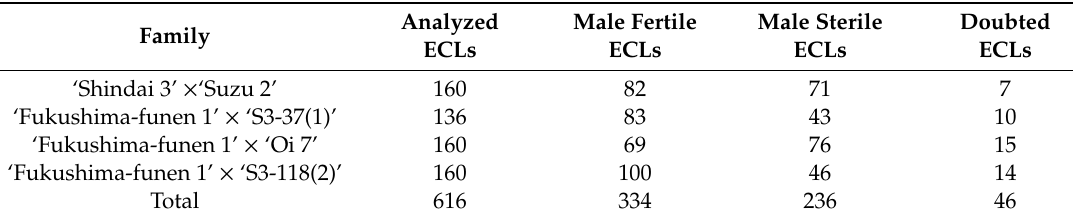
Table 2. Summary of marker-assisted selection (MAS) for the male sterility allele ms1 in four sugi seed families. Data represent the overall result of analyzed embryogenic cell lines (ECLs) derived from four collection dates for each